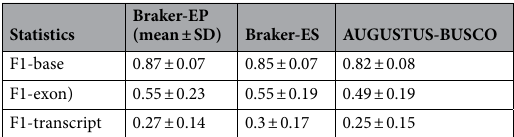
Table 1. Accuracy of the gene prediction methods at different loci